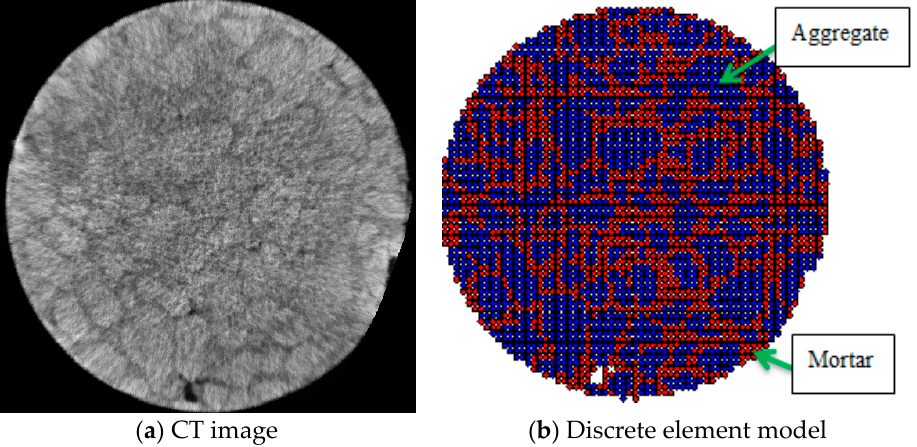
Figure 3. The computed tomography (CT) image and the corresponding discrete element model.